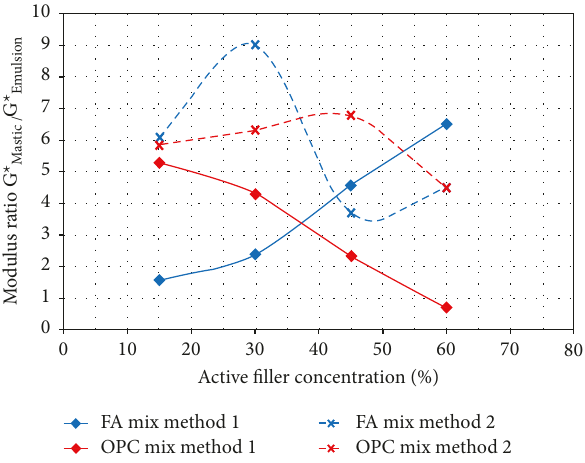
Figure 8: Average stiffness ratio for mixing methods 1 and 2 for OPC and FA